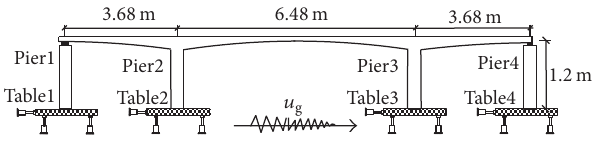
Figure 9: Dimensions of specimen.